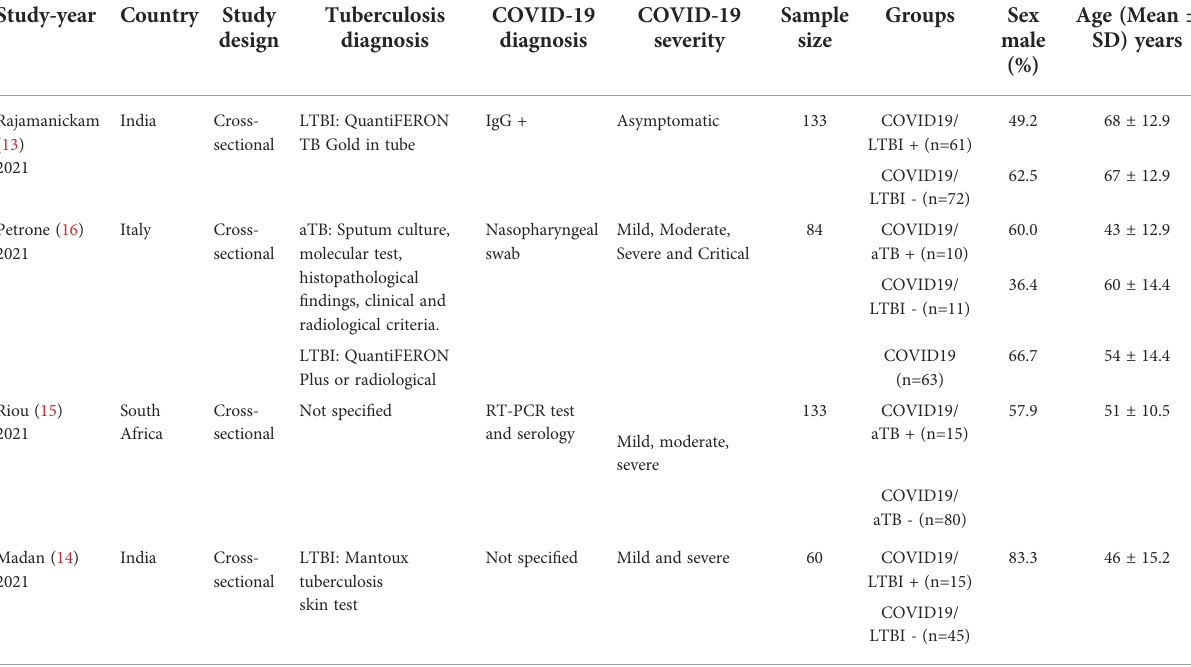
TABLE 1 Characteristics of the studies that evaluated the immune response in tuberculosis and COVID19 coinfection